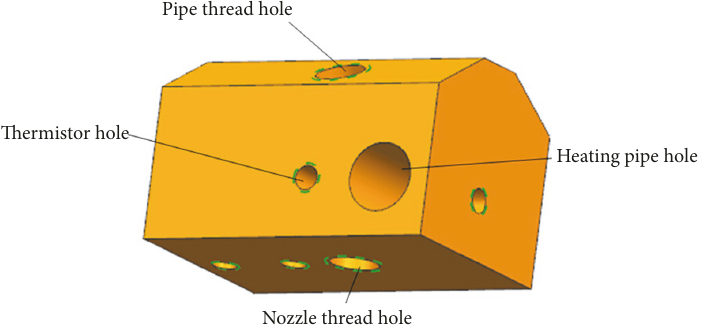
Figure 1: Model of the heating block.